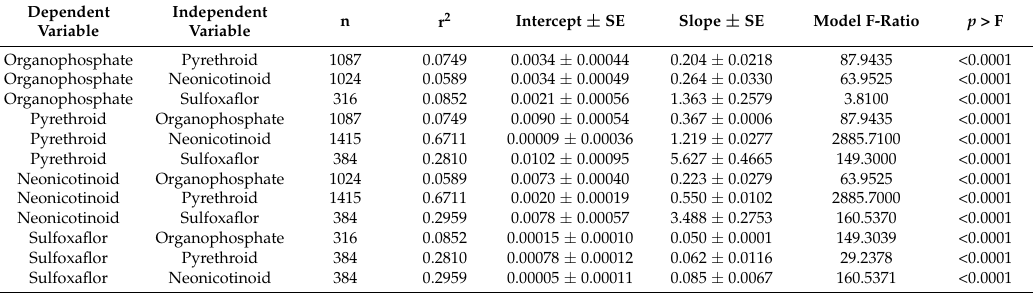
Table 7. Linear regressions between estimated use (kg ai/ha harvested cropland) of organophosphate, pyrethroid, neonicotinoid, and sulfoxaflor insecticides across all counties/parishes in Arkansas, Louisiana, and Mississippi,